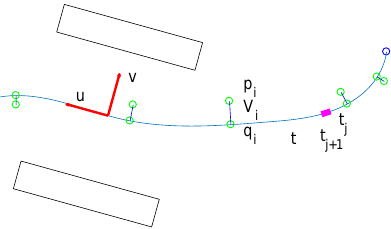
Figure A3. A schematic presentation of the trail center line matching. A convolution filter positioned at q ( t ) ∈ S ( a ) has been outlined. A sub-segment [ t j , t j + 1 ] ∈ T is shown with a thick line. The local coordinate frame ( u , v ) can also be seen in Figure